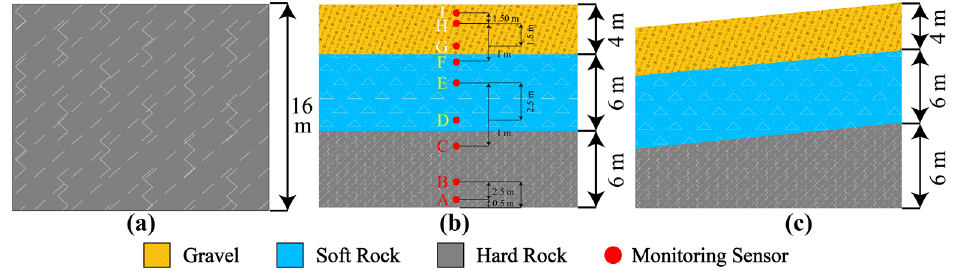
Figure 3. Geological section of the horizontally layered field and layout of the measuring points A-I in the models: ( a ) homogeneous site (Model 1), ( b ) horizontally layered site (Model 2) and ( c ) tilted layered site (Model 3).